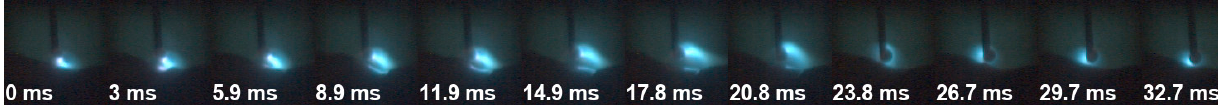
Figure 10. DCEN cathode spot wandering.